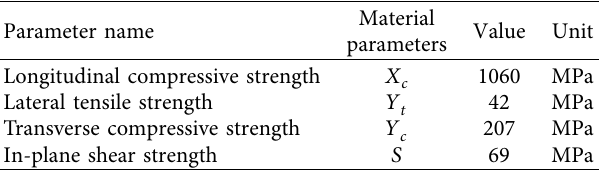
Table 2: Material parameters of AS4/3602.